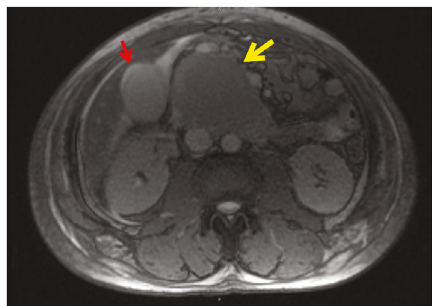
Figure 1: MRI of abdomen T2 sequence showed a moderately T2 hyperintense, round, well-circumscribed homogeneous mass, measuring approximately 6.3 × 5.9 × 8.2 cm, arising off the head of the pancreas (yellow arrow). There was also a mild thickening of gallbladder wall (red arrow).